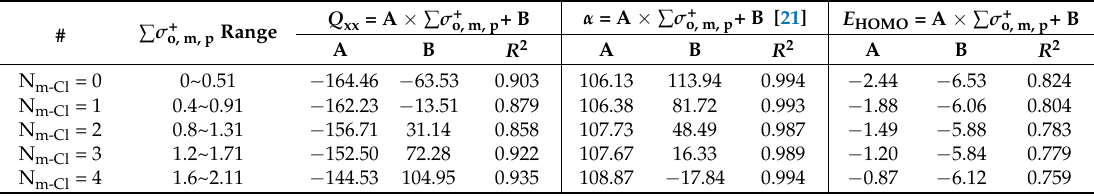
Figure 2. The relationship of ∑ σ + o, m, p and quadrupole moment tensor along the x axis ( Q xx ), polarizability ( α ) [21] and energy of the highest occupied molecular orbital ( E HOMO ) for PCBs congeners. The N m-Cl represents the number of Cl atoms substituted at the meta-position, ranging from 0 to 4 with the number of congeners n = 21, 48, 72, 48, and 21, respectively. ( a ) ∑ σ + o, m, p and Q xx ; ( b ) ∑ σ + o, m, p and α ; ( c ) ∑ σ + o, m, p and E HOMO . Table 1. The fitted linear equations of ∑ σ + o, m, p with Q xx , α and E HOMO for PCBs congeners.